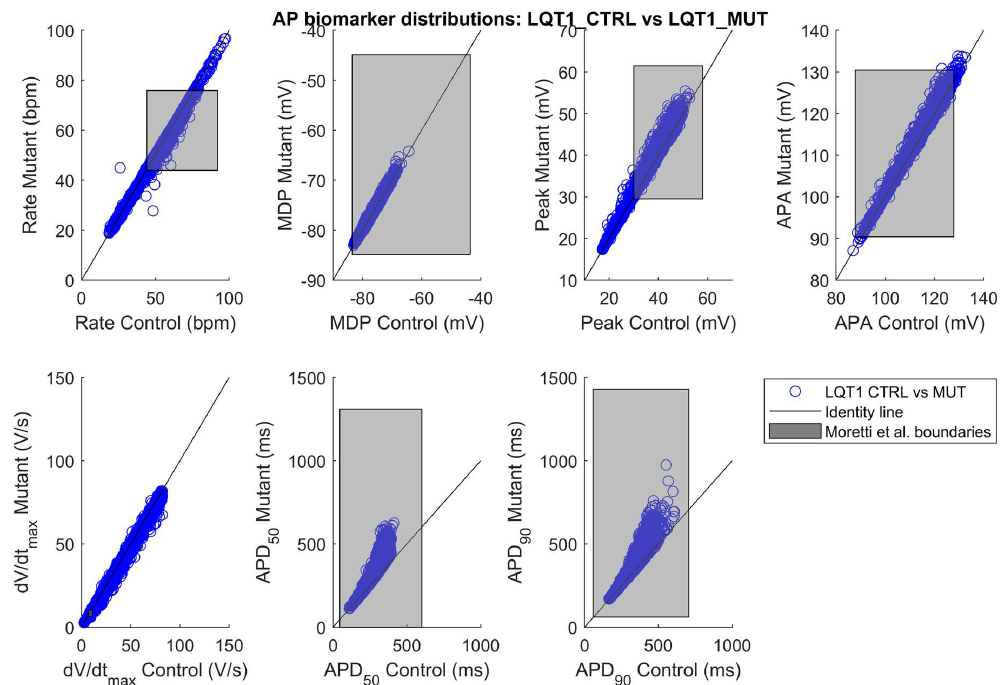
Figure 3. AP biomarker distributions in the populations LQT1_CTRL vs. LQT1_MUT (blue circles). The black lines represent the identity lines, i.e., when the AP biomarkers are equals in LQT1_CTRL and LQT1_MUT. The grey rectangles represents the boundaries built on the experimental data from the Moretti 2010 [3] control and mutant datasets, obtained in spontaneously beating hiPSC-CMs (see Table 2): lower bound (mean − 2SD) and upper bound (mean + 2SD) for each AP biomarker.